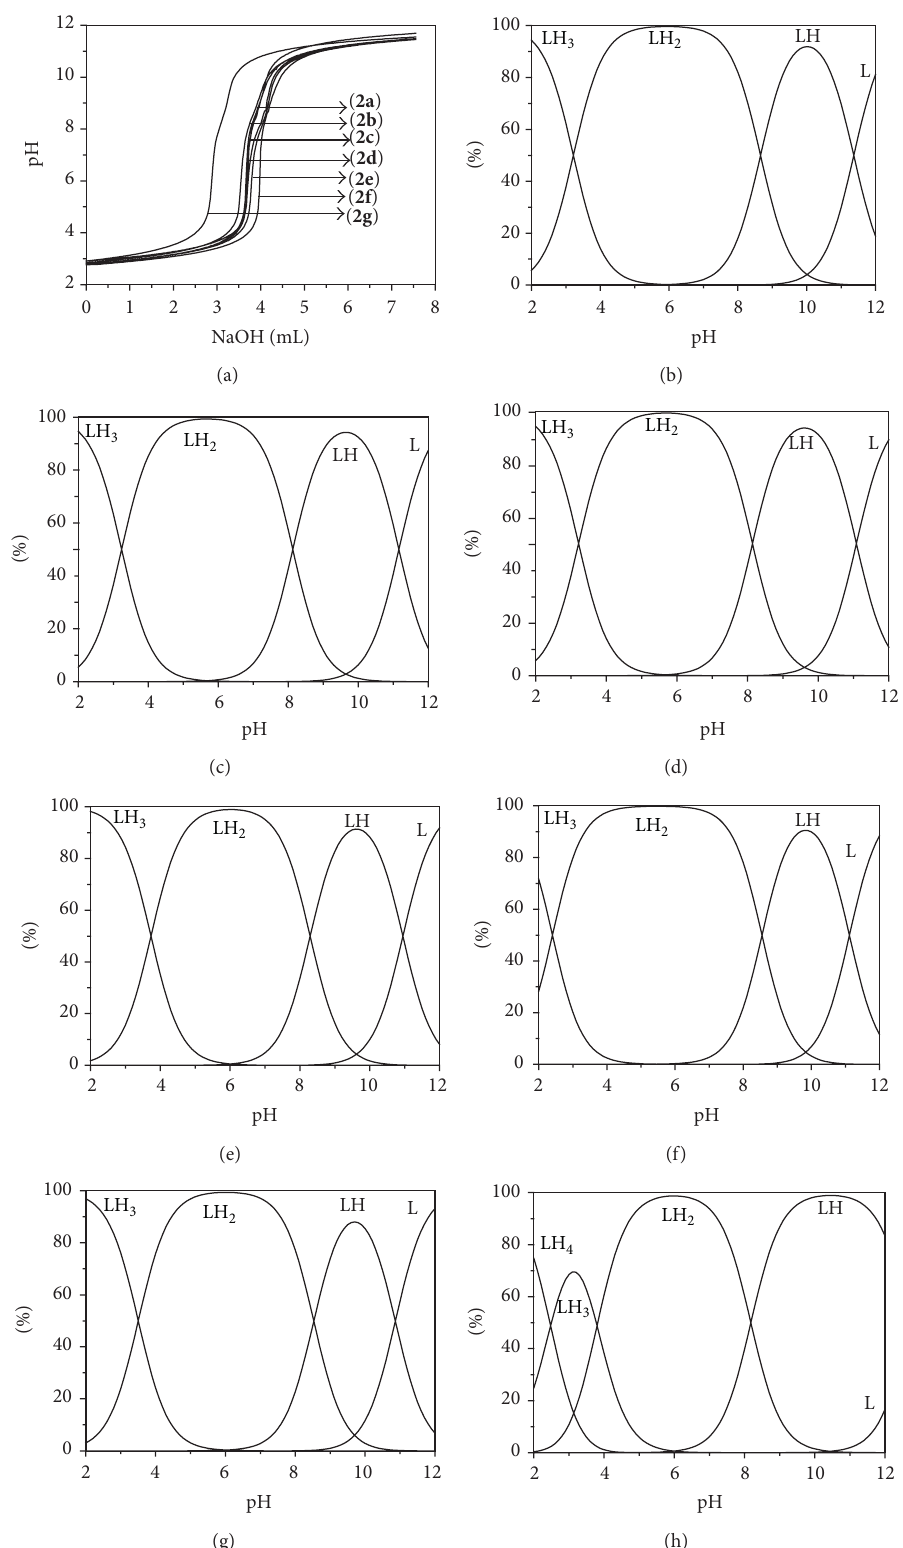
Figure 2: Potentiometric titration curves (a) and distribution curves of ligands ((b) 2a (c) 2b (d) 2c (e) 2d (f) 2e (g) 2f (h) 2g ) (20% (v/v) ethanol-water mixed, 25.0 ± 0.1 ∘ C, 𝐼 = 0.1 mol/L by